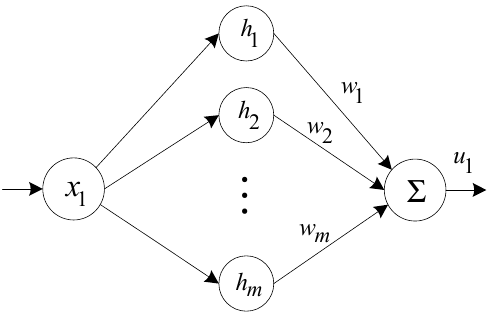
Figure 4. The structure of RBF neural network.